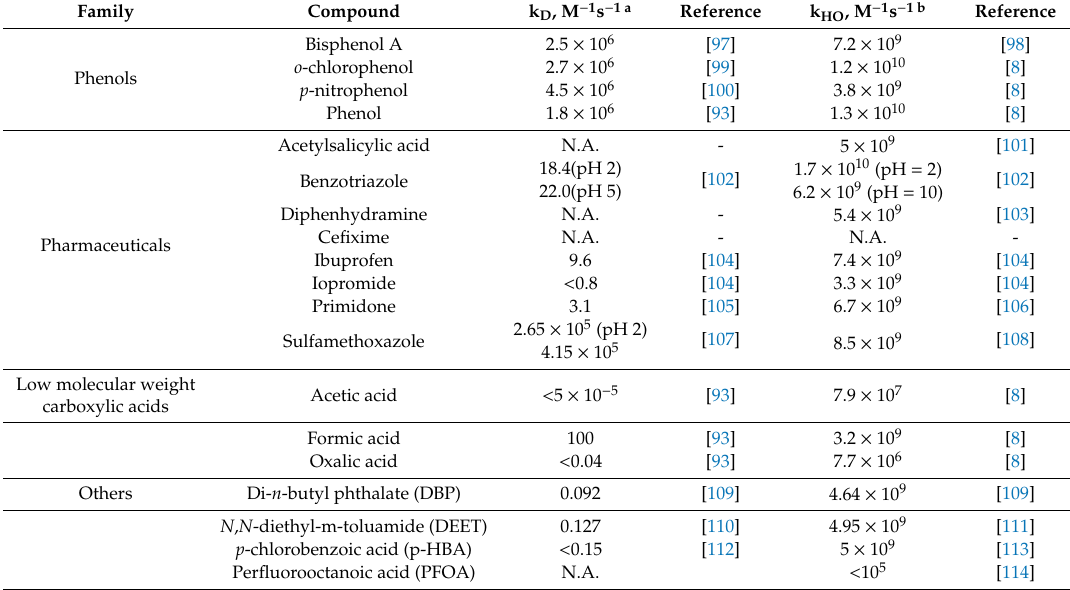
Table 1. List of target pollutants used in ozonation processes catalysed by graphene-based materials. Rate constants of reactions with ozone, k D , and hydroxyl radical, k HO